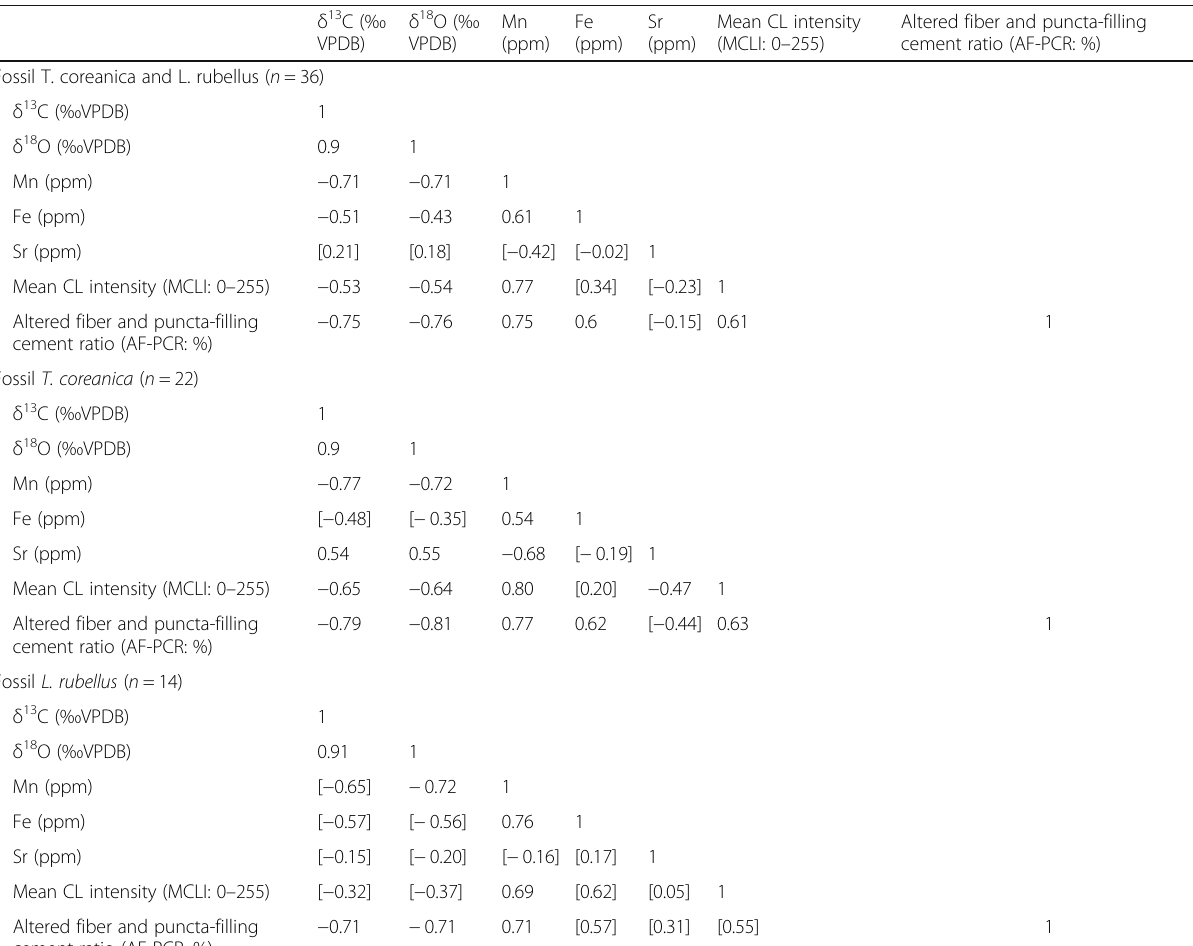
Table 3 Cross-correlations between geochemical, microstructural and optical signals in the studied fossil brachiopodCross- correlations are calculated between isotope composition ( δ 13 C and δ 18 O), minor-element (Mn, Fe, and Mn) concentrations, MCLI, and AFR or Α F-PCR of the fossil Terebratalia coreanica and Laqueus rubellus shells. Coefficient values in brackets are not statistically significant ( p >